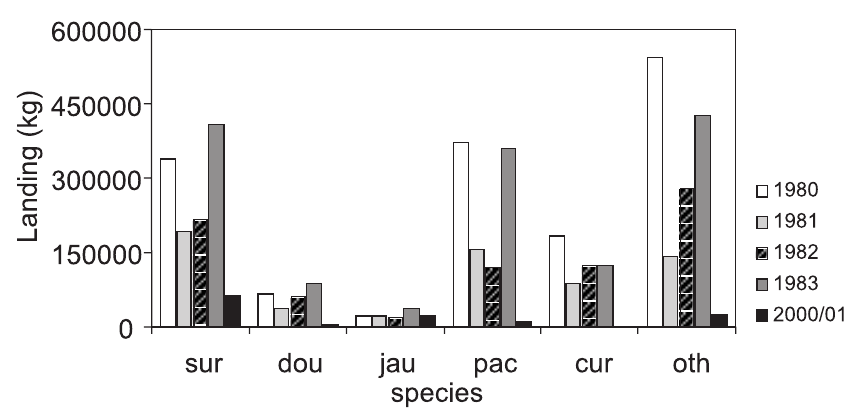
Fig. 9. Comparison of landing by species in the early 80s and today for the rio Cuiabá basin (sur = surubim; dou = dourado; jaú = jaú; pac = pacu; cur = curimbatá; oth = other